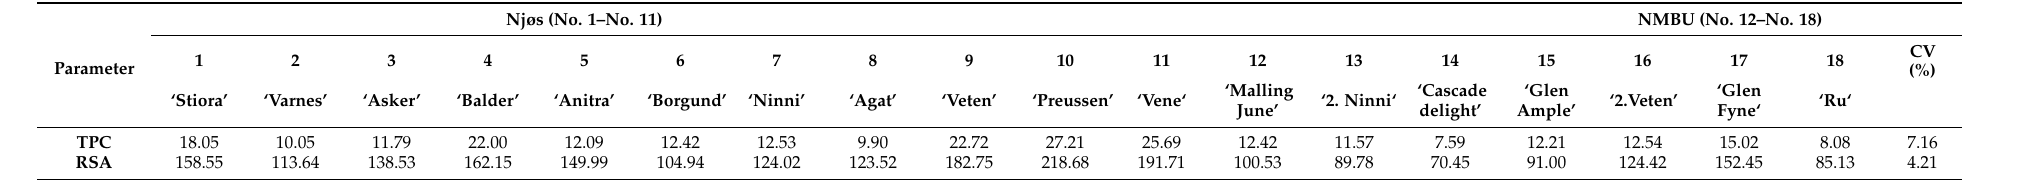
Table 4. The averages of the values of TPC (g GAE/kg) and RSA (mmol TE/kg) in 18 raspberry extract samples during the two-year collection from two Norwegian